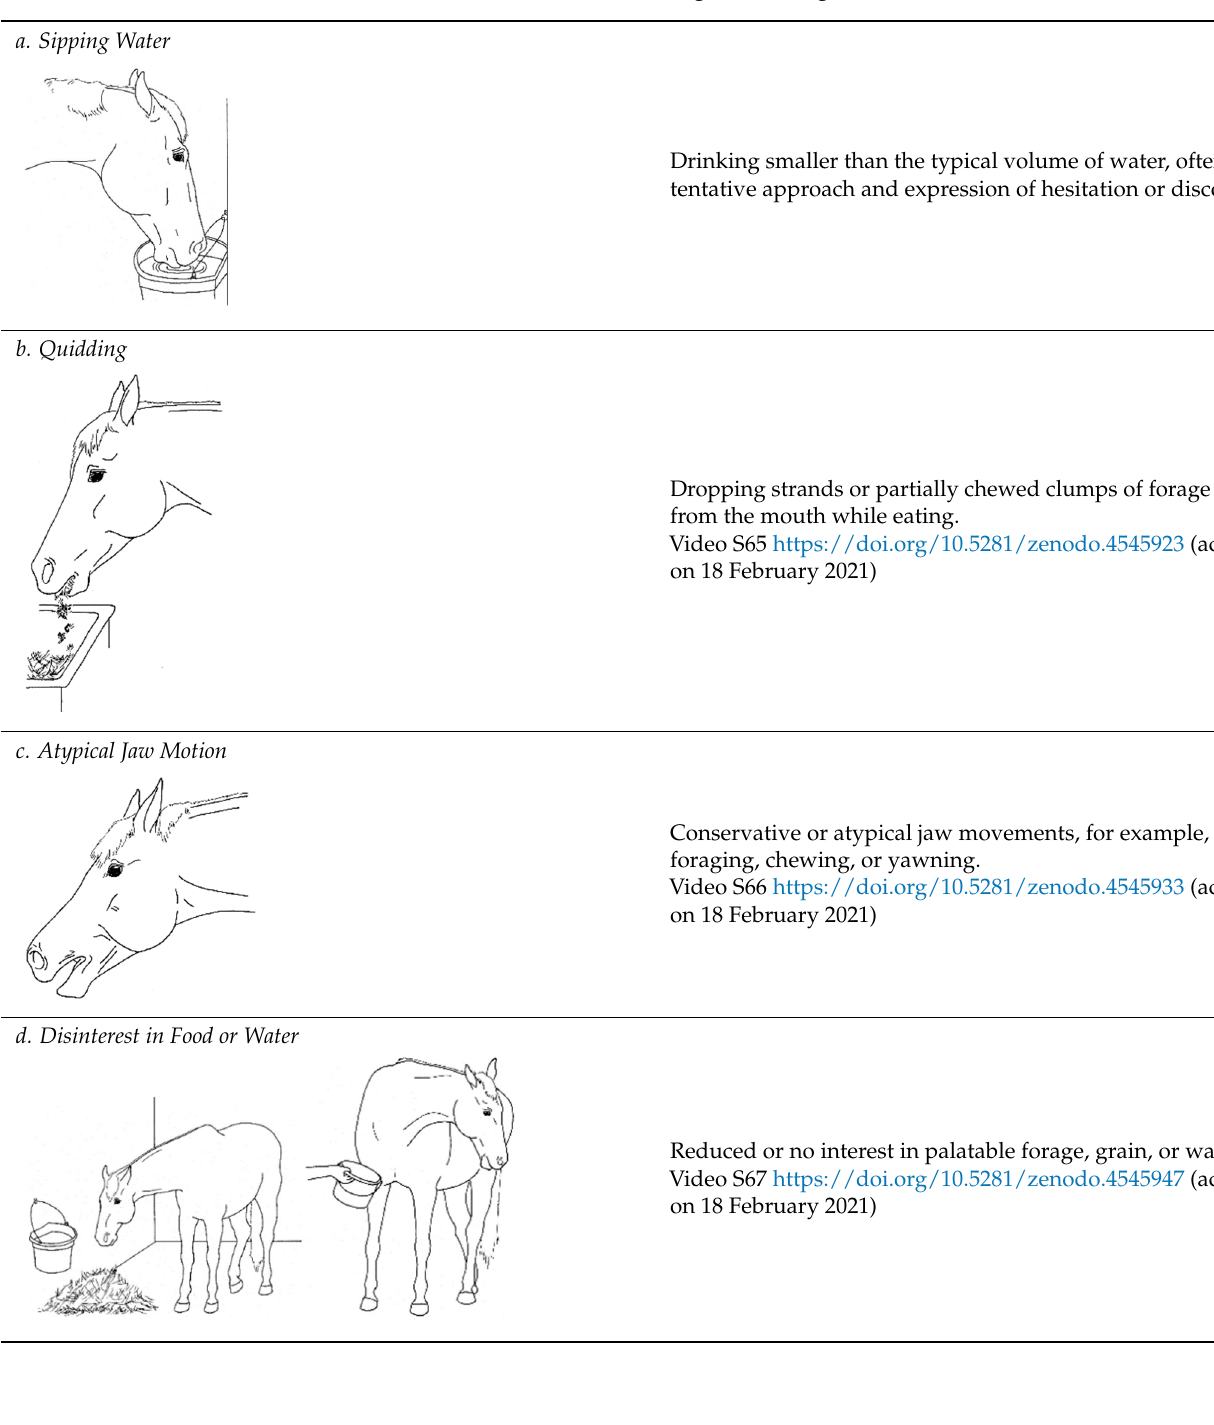
Table 8. Vocalizations/audible sounds. a.